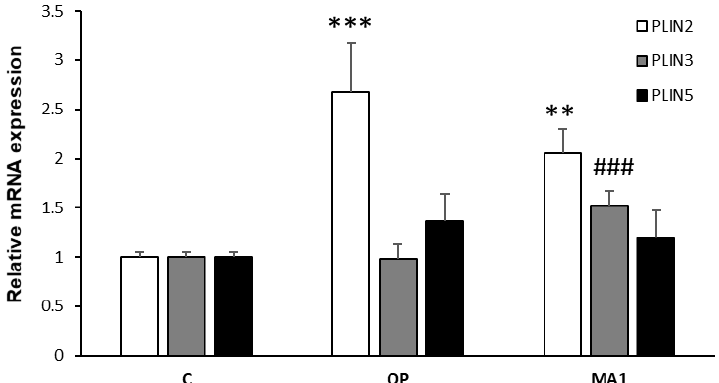
Figure 3. Effects of MA1 on PLIN expression in steatotic FaO cells. Relative expression of PLINs as evaluated by real-time PCR. Steatotic FaO cells (OP) were then incubated for 24 h in the presence of 10 µ g/mL MA1. Data are mean ± SD of three independent experiments and are expressed with respect to controls. Significant differences are denoted by symbols on bars (** p ≤ 0.01, *** p ≤ 0.001 vs. control; ### p ≤ 0.001 vs. OP).